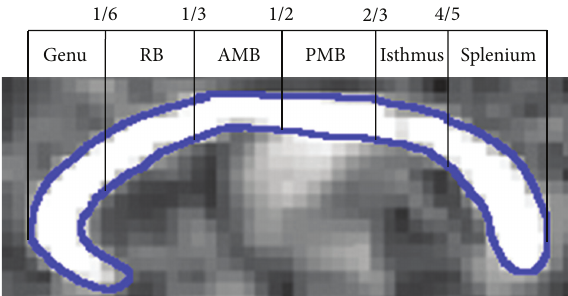
F 1: Corpus callosum segmentation schema adapted for ne- onates by ompson et al. [10]. RB: rostral body; AMB: anterior midbody; PMB: posterior